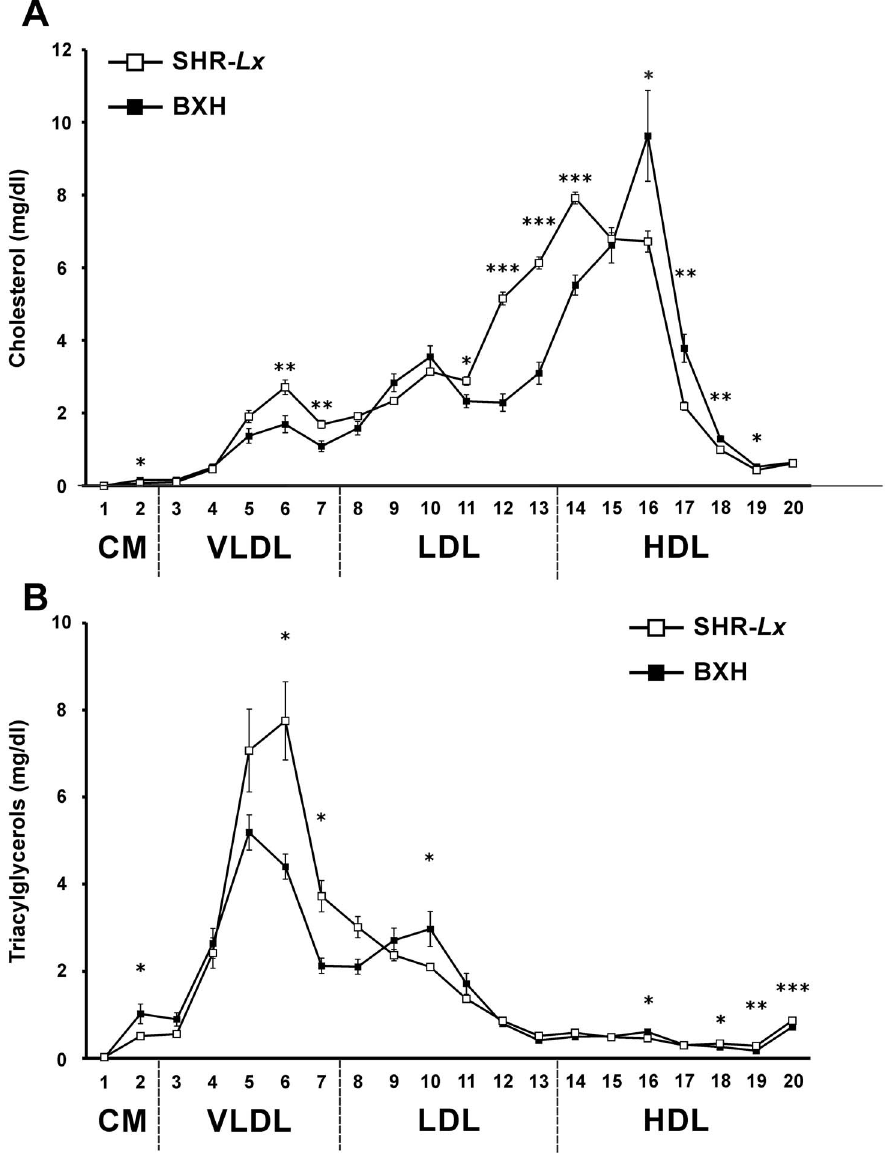
Figure 2. Fasting cholesterol (A) and triacylglycerol (B) content in 20 lipoprotein subfractions in SHR- Lx (squares) vs. BXH2 (diamonds) adult male rats after one week of high-sucrose diet. Within the graph, the significance levels of strain comparison by post-hoc Tukey’s HSD test are shown as follows: *…p , 0.05; **…p , 0.01; ***…p , 0.001. The allocation of individual lipoprotein subfractions to major lipoprotein classes is shown in order of particle’s decreasing size from left to right. CM - chylomicron, VLDL - very low-density lipoprotein, LDL - low density lipoprotein, HDL - high-density lipoprotein.